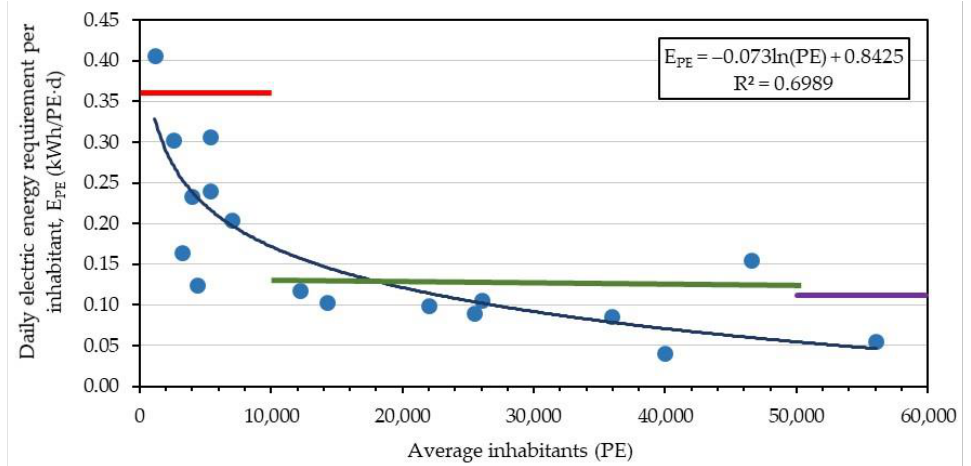
Figure 5. Blue points: daily electric energy requirement per inhabitant, E PE (kWh / PE · d) for the 17 examined WWTPs; blue line: trend line E PE = − 0.073 ln (PE) + 0.8425 with R 2 = 0.6989; red, green, and purple lines: average E PE for WWTPs serving up to 10,000, 10,000 to 50,000, and above 50,000 PE, respectively, reported by Dimopoulou [12].